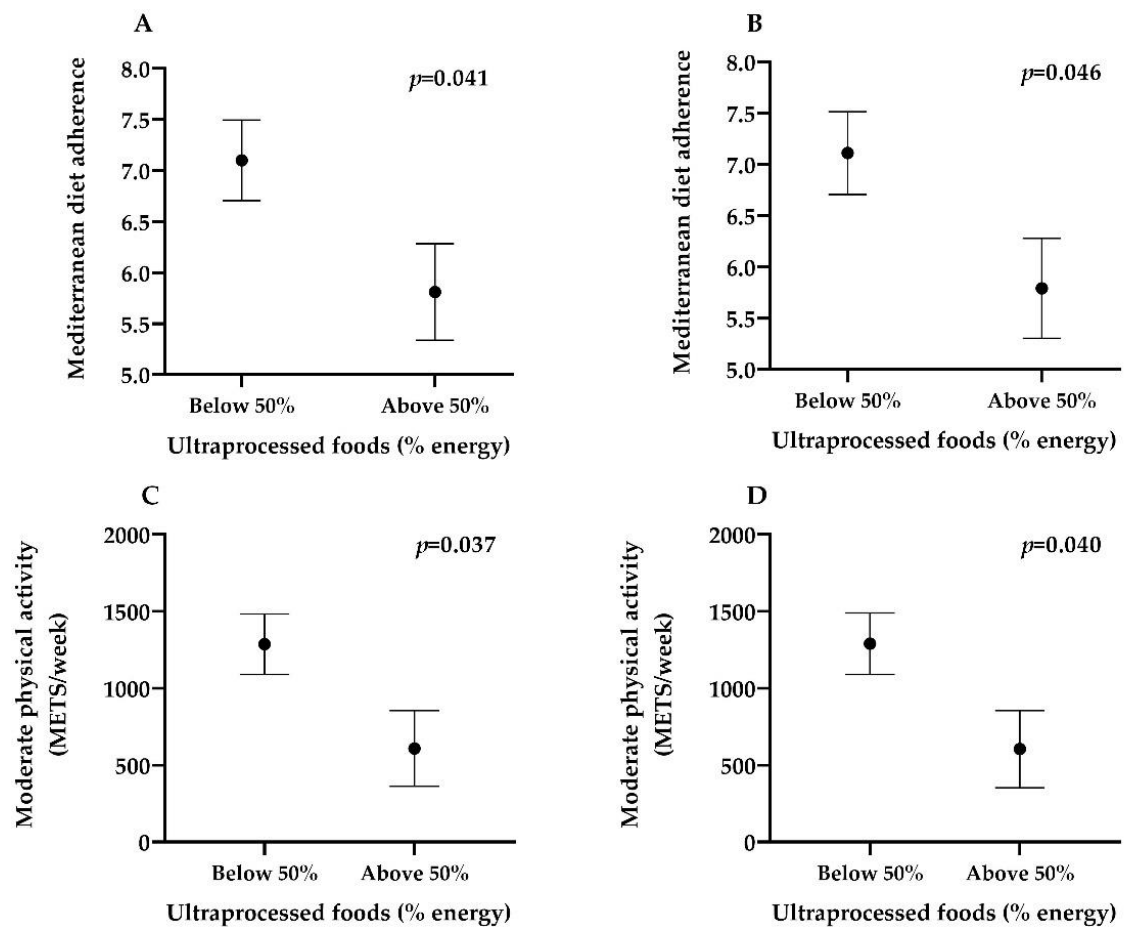
Figure 1. Mediterranean diet adherence and moderate physical activity levels (METS/week) by percentage of energy consumed from ultra-processed foods. Dots represent mean and bars represent standard error. ( A ) Mediterranean diet adherence by energy intake from ultra-processed foods below 50% vs. energy intake from ultra-processed foods above 50%. Model unadjusted. ( B ) Mediterranean diet adherence by energy intake from ultra-processed foods below 50% vs. energy intake from ultra-processed foods above 50%. Model adjusted for age, sex and following a gluten free diet for at least 18 months. ( C ) Moderate physical activity (METS/week) by energy intake from ultra-processed foods below 50% vs. energy intake from ultra-processed foods above 50%. Model unadjusted. ( D ) Moderate physical activity (METS/week) by energy intake from ultra-processed foods below 50% vs. energy intake from ultra-processed foods above 50%. Model adjusted for following a gluten free diet for at least 18 months.